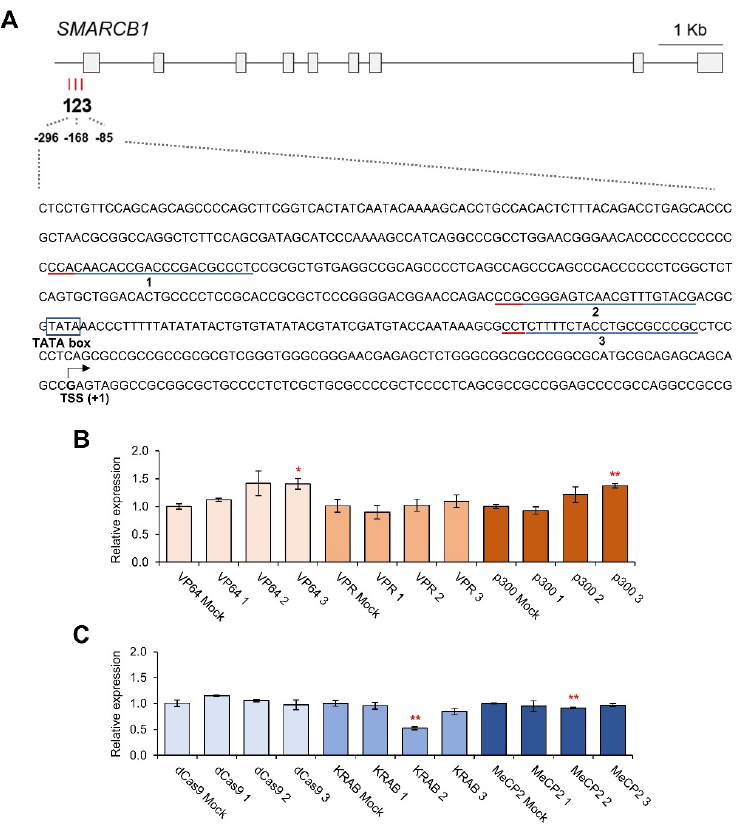
Figure 3. The regulation of the chicken SMARCB1 gene expression by individual gRNAs in CRISPRa and CRISPRi DF-1 cells. ( A ) Gene structure of SMARCB1 gene and the location of gRNAs (1, 2 and 3). The number indicates the position of gRNAs. Grey rectangles indicate exons. Scale bars, 1 Kb. TATA box and transcription start site (TSS) are marked. The blue bar indicates the gRNA binding site, and the red bar indicates the protospacer adjacent motif sequence (PAM). Quantitative analysis in the individual gRNA-treated CRISPRa DF-1 cell lines ( B ), and CRISPRi DF-1 cell lines ( C ). Data are shown as the mean ± SEM. Signi fi cant di ff erences between the mock controls and gRNAs-trans- fected samples were determined by Student’s t -test. Statistical signi fi cance was ranked as * p < 0.05, ** p < 0.01